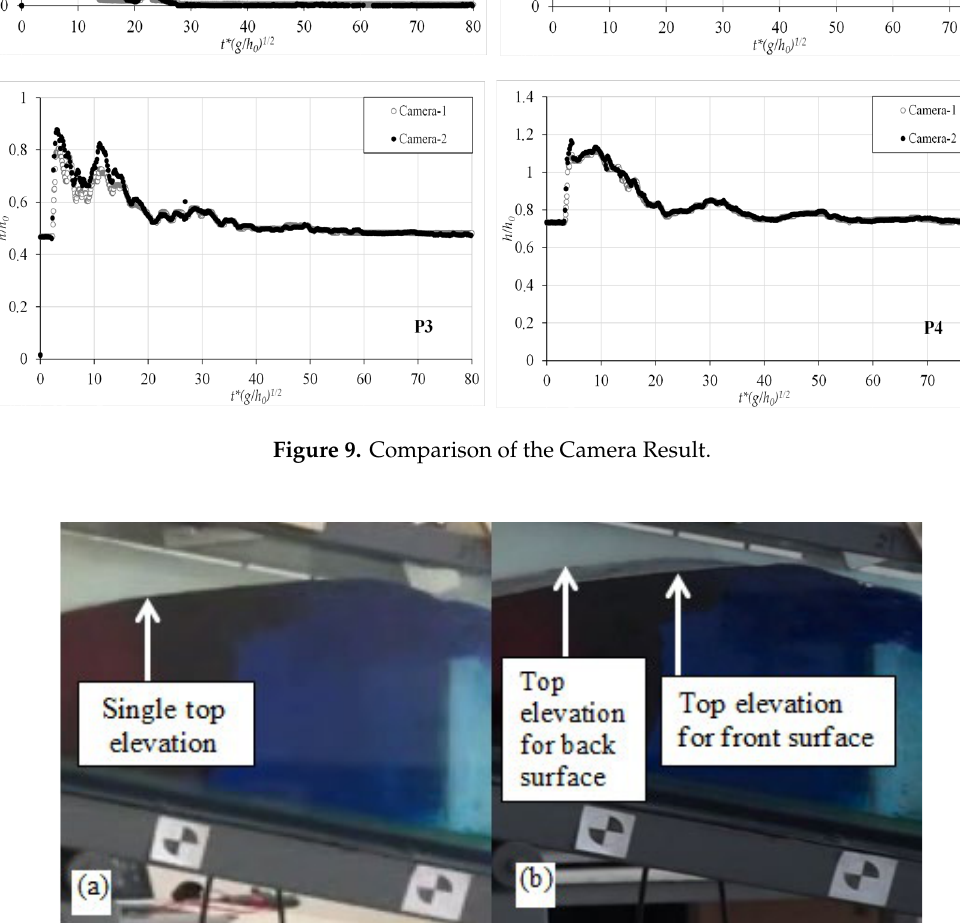
Figure 9. Comparison of the Camera Result.